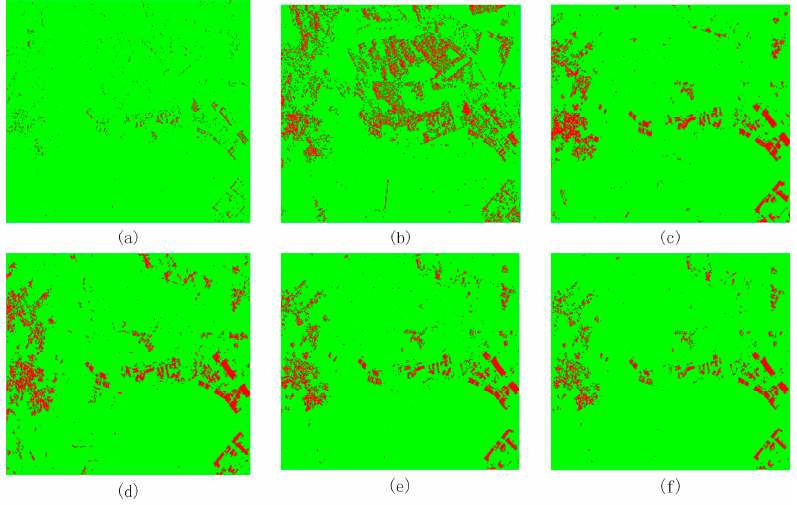
Figure 4. ESAR image building extraction results. ( a ) Quan’s threshold extraction method; ( b ) PauliRGB and G 0 statistical texture parameters using SVM results; ( c ) RVCNN; ( d ) PFDCNN; ( e ) PauliRGB and G 0 Statistical texture parameters using CNN; ( f ) as the result of introducing superpixel constraints in ( e ).